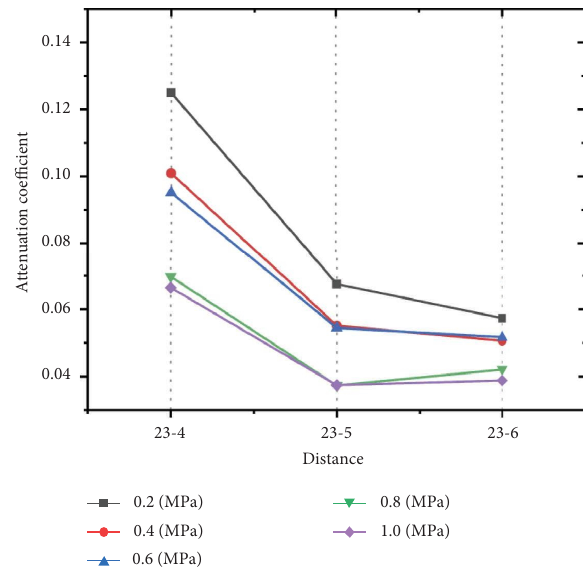
Figure 10: Variation of the leakage acoustic signal RMS value of A and D leakage with the distance under diferent